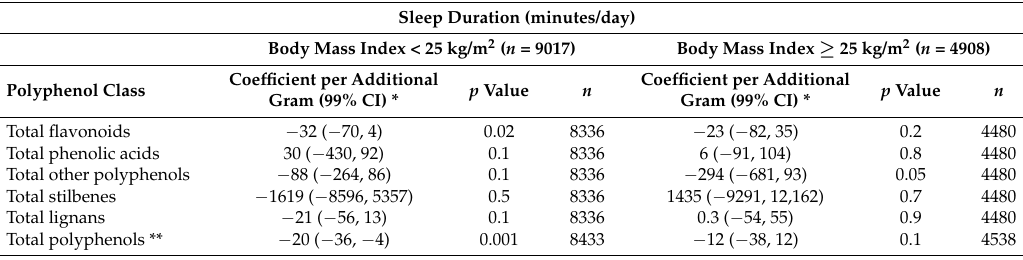
Table A2. Prospective associations between polyphenol content from fruit and vegetable intakes and sleep duration for women from the UKWCS stratified by BMI.